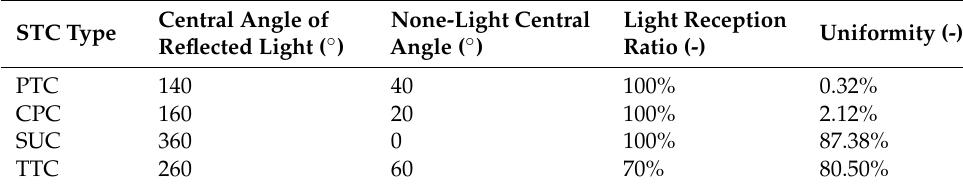
Figure 9. ( a ) SUC solar ray tracing results (including enlarged view near the absorber tube), ( b ) average circumferential solar radiation at the cross-section, ( c ) upper surface solar radiation distribution along the radial direction, ( d ) lower surface solar radiation distribution along the radial direction. Table 2. Comparison of optical results of four